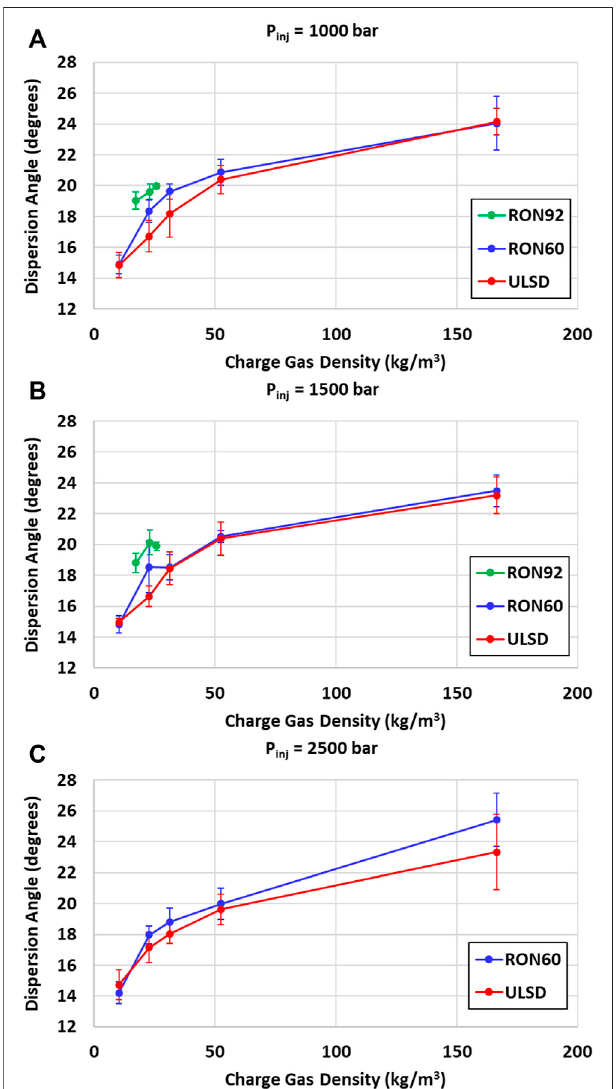
FIGURE 11 | Non-vaporizing dispersion angle vs. charge gas density using60%penetrationcriterionat (A) P inj =1,000bar, (B) P inj =1,500bar,and (C) P inj = 2,500